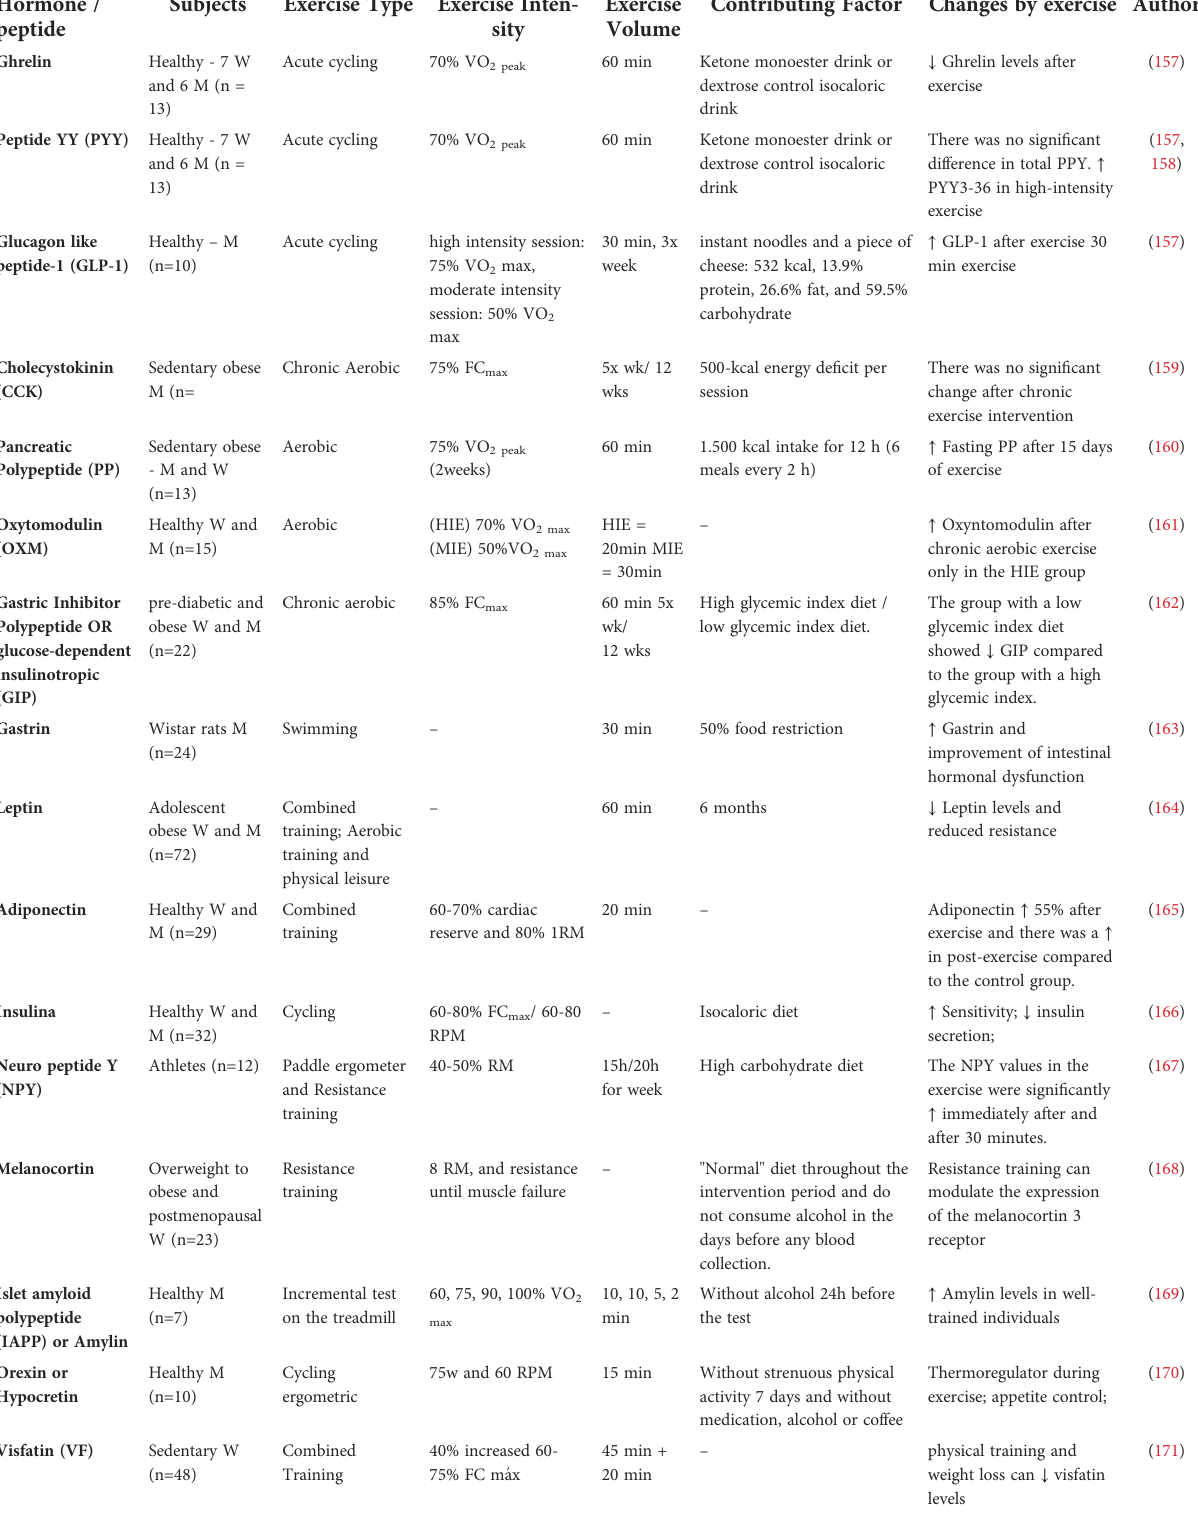
TABLE 2 Possible changes by acute and chronic exercise in hormones/peptides that participate in MGB